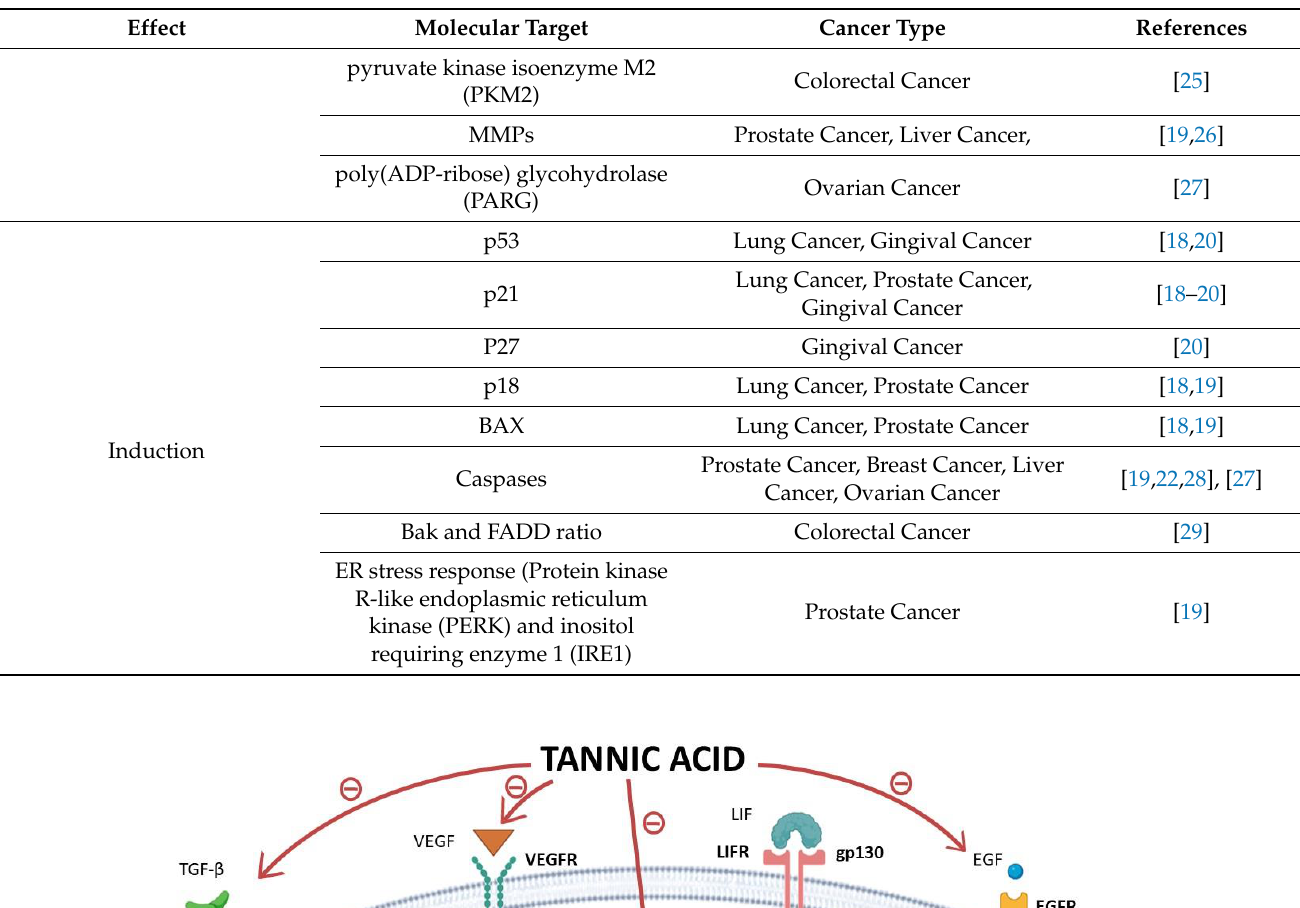
Table 1. Molecular targets of tannic acid (TA) in various neoplastic diseases.